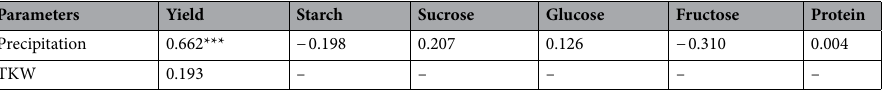
Table 4. Pearson correlation analyses (r) between environmental parameter (precipitation), and grain yield and quality traits of the Rothamsted Broadbalk experiment. A statistically significant effect is indicated with *** for p < 0.001. ‘–’ indicates unavailable coefficient of correlation (r).